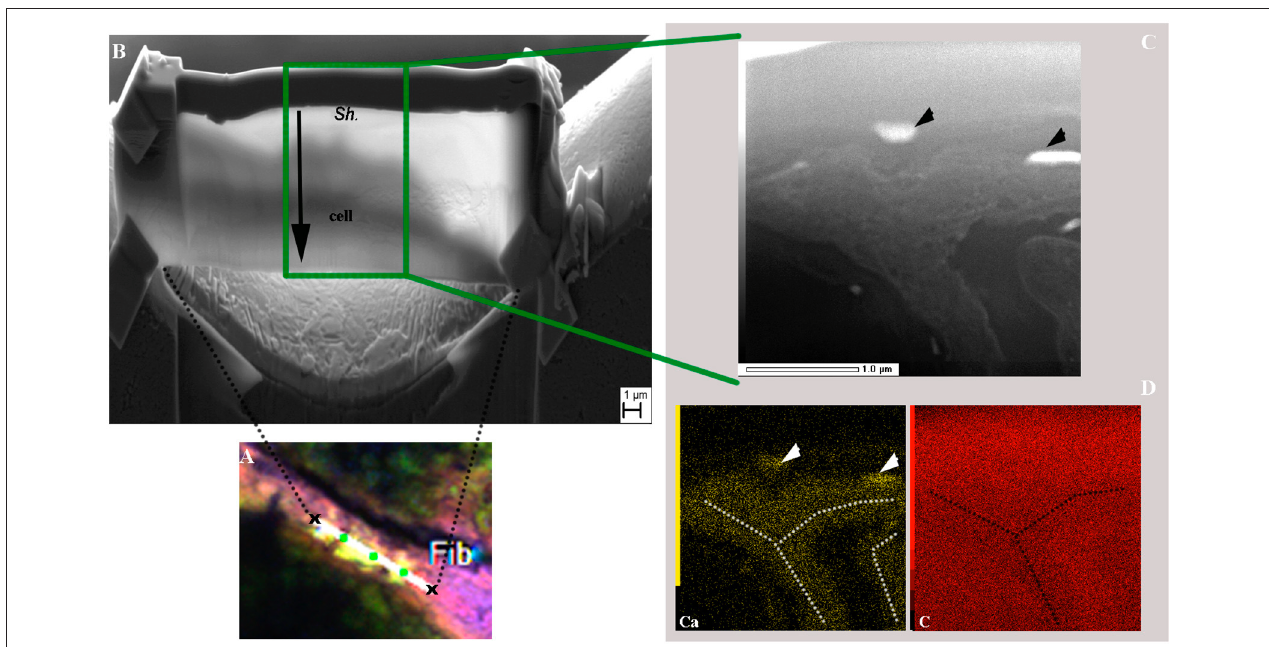
FIGURE 8 | SEM and TEM observations of a FIB section longitudinally milled on a cyanobacteria filament stained with calcein as shown in the CLSM image displayed in (A) (see Supplementary Figure S3 for location of the selected area and associated scale). (B) SEM image of the ultrathin section after milling. The upper part of the section corresponds to the filament sheath ( Sh. ) and the lower part (end of black arrow) to the cyanobacteria cell. (C) HAADF-STEM image of the FIB section showing the filament along its longer axis and the different phases within the filament. The black arrowheads indicate regions with strong electron absorption. (D) Associated STEM-EDXS elemental maps for calcium (Ca; in yellow) and carbon ( C ; in red) displaying opposite distributions. Ca-rich areas are highlighted by white arrowheads and white dotted